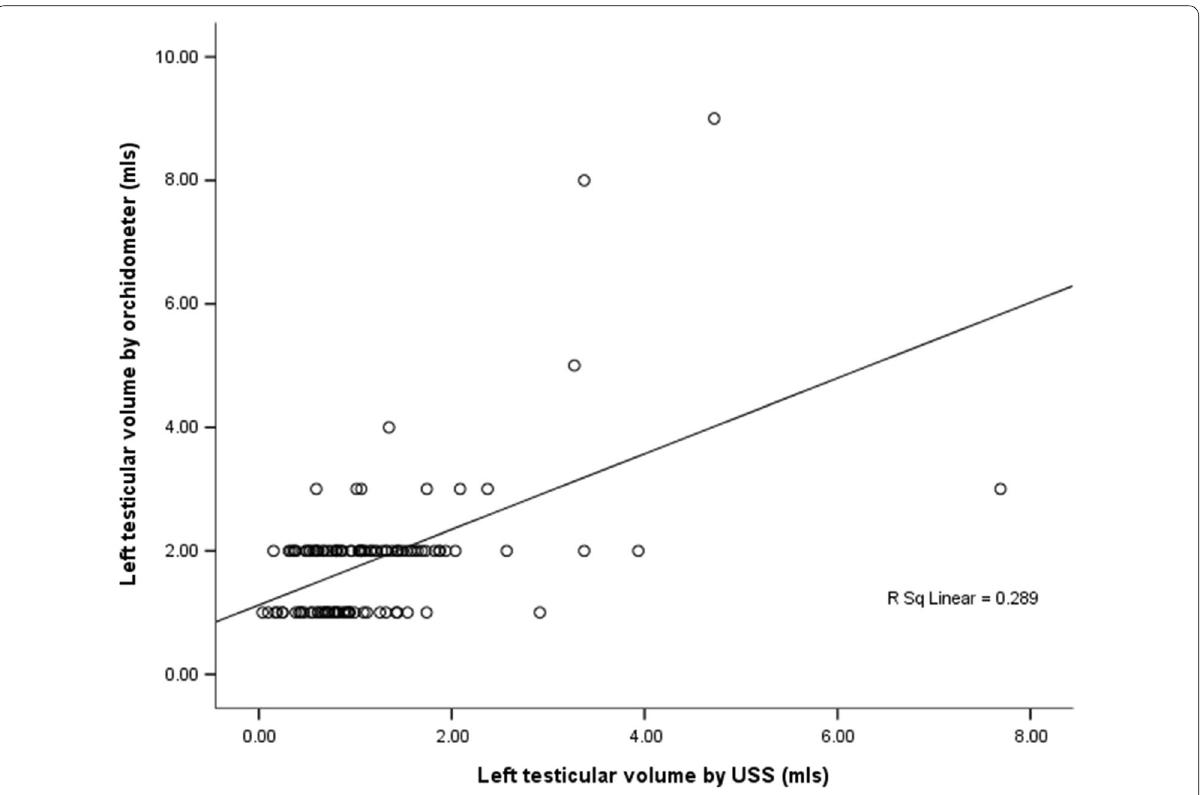
Fig. 2 Scatter plot of left testicular volume measurements by orchidometry and